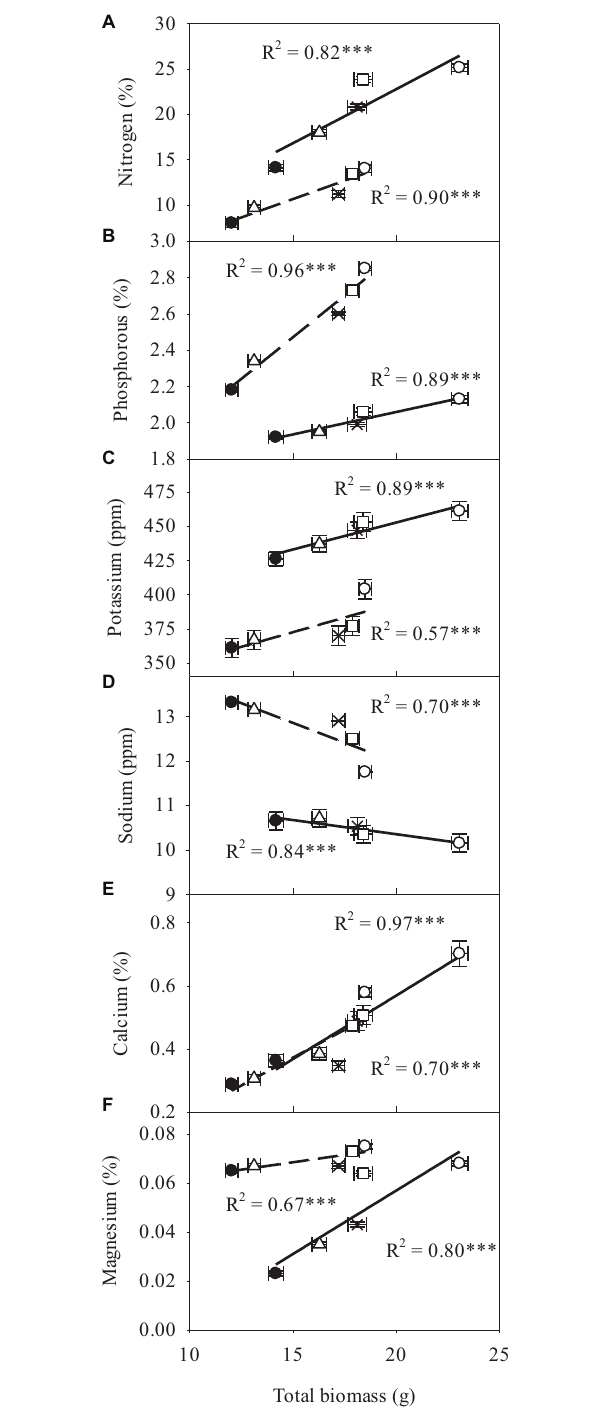
FIGURE 5 | Relationship of total plant oven-dried biomass with nitrogen (A) , phosphorus (B) , potassium (C) , sodium (D) , calcium (E) , and magnesium (F) in the roots of Acacia modesta (solid lines) and Adhatoda vasica (dashed lines) in T 0 (filled circles), T 1 (empty triangles), T2 (multiplication symbol), T3 (empty squares), and T4 (empty circles). Each symbol indicates the mean ± SE. ∗∗∗ P < 0.0001, all the relationships were significant. Linear function was fitted for all the